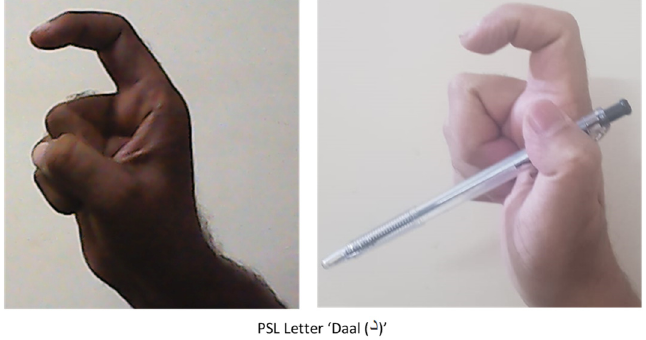
Figure 23. Detecting other objects—pen.